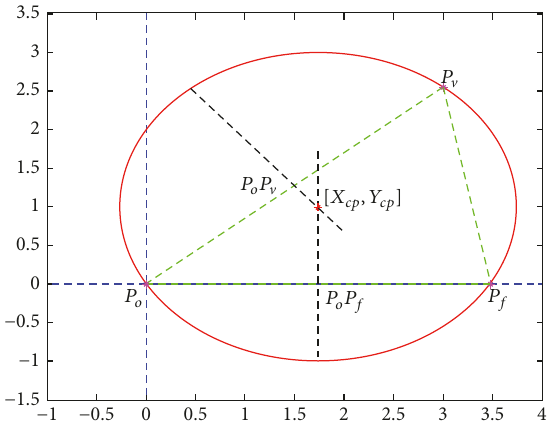
Figure 9: Construction of the circle, using the perpendicular bisectors 𝑃 𝑜 𝑃 V and 𝑃 𝑜 𝑃 𝑓